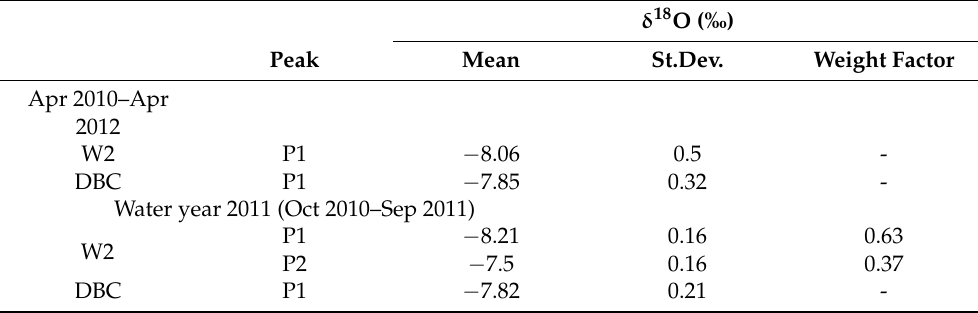
Table 7. Parameter estimates of the groundwater δ 18 O values obtained by Gaussian mixture mod- elling for the entire study period (April 2010–April 2012) and the water year 2011. P1 and P2 correspond to individual peaks of a density estimate. W2—Martinš´cica well 2, DBC—Dobrica spring. δ 18 O (‰) Peak Mean